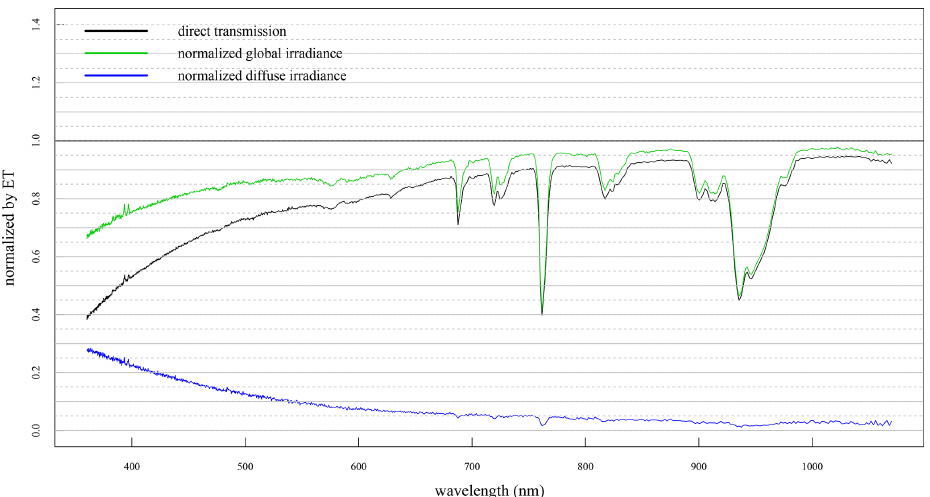
Figure 6. The direct transmission and normalized global and diffuse irradiances on a clear day (27 October 2009) at the ARM site in northern Oklahoma. Note that both the direct normal transmission and the horizontal component of direct normal transmission, which is dni · cos ( sza), where sza is the solar zenith angle, would have the same transmission profile. Note, also, that the direct transmission plus the normalized diffuse irradiance sum to the normalized global